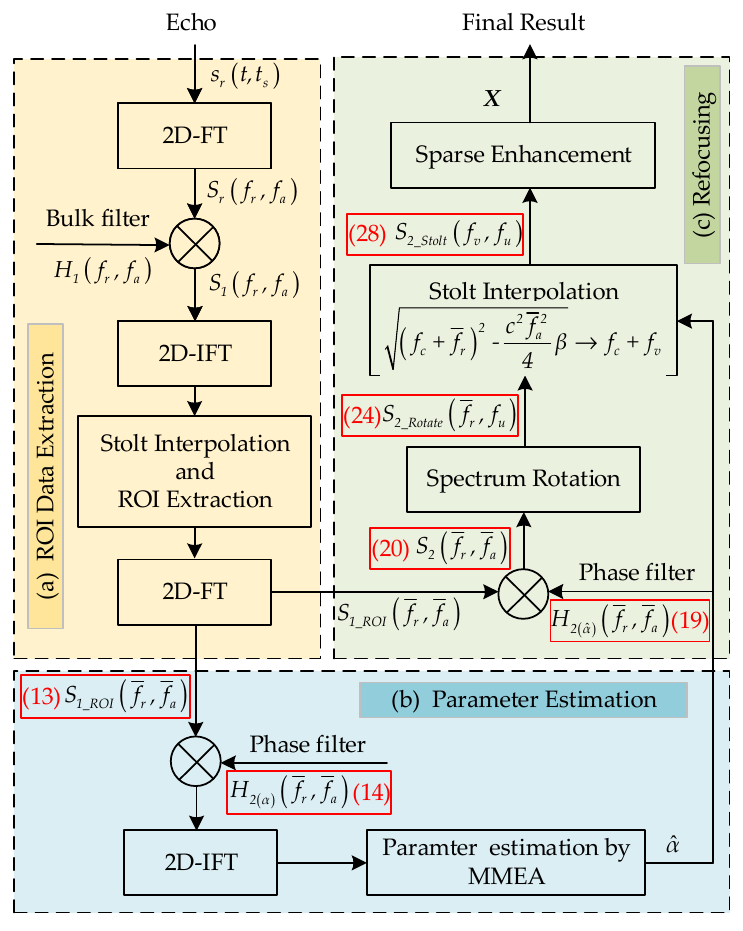
Figure 2. Flow chart of proposed method.